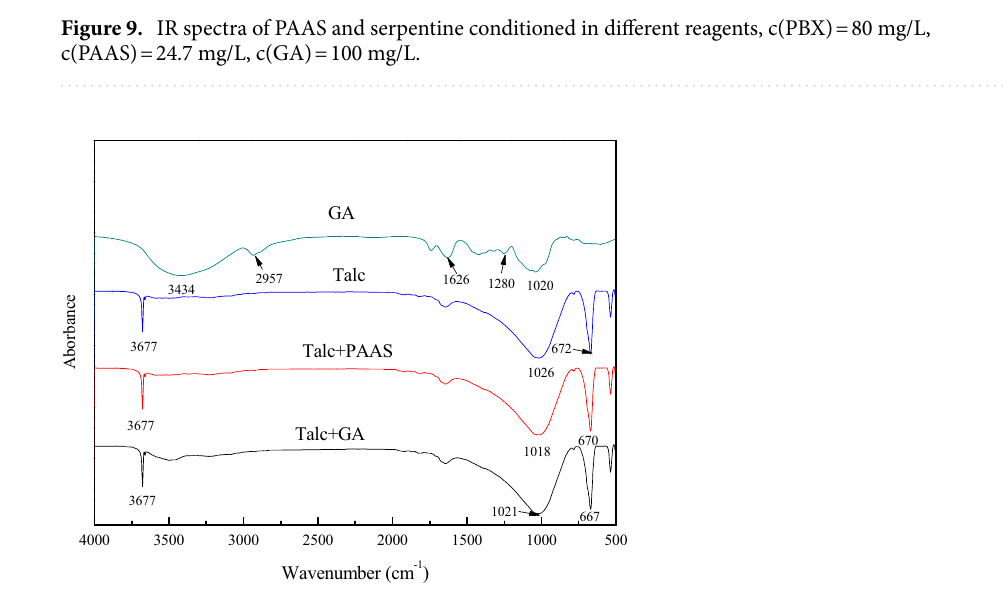
Figure 10. IR spectra of GA and talc conditioned in different reagents, c(PBX) = 80 mg/L, c(PAAS) = 24.7 mg/L, c(GA) = 100